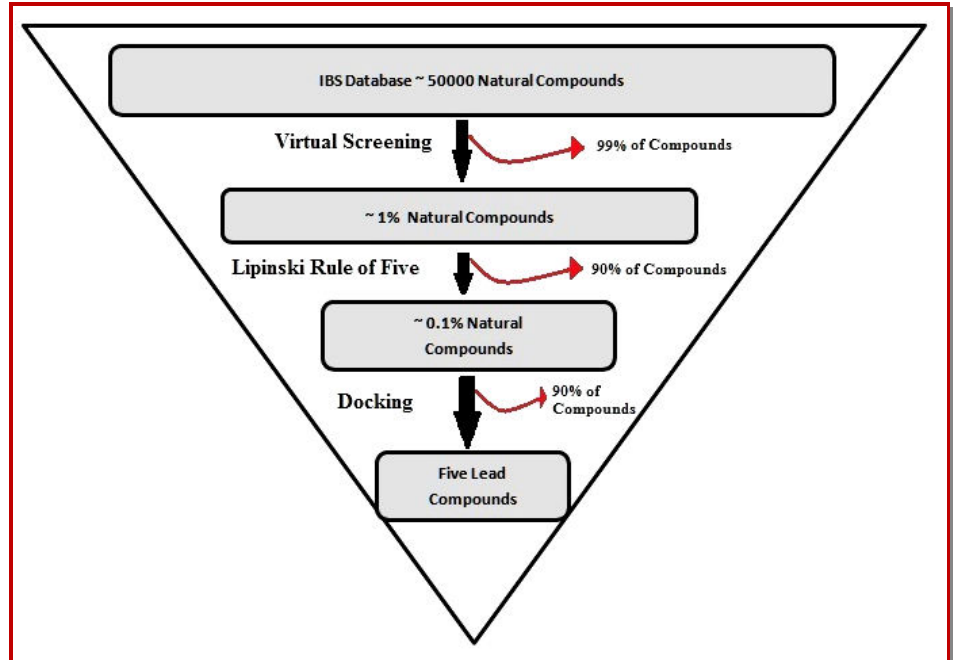
Figure 3: 2D docked conformation of five lead compounds with